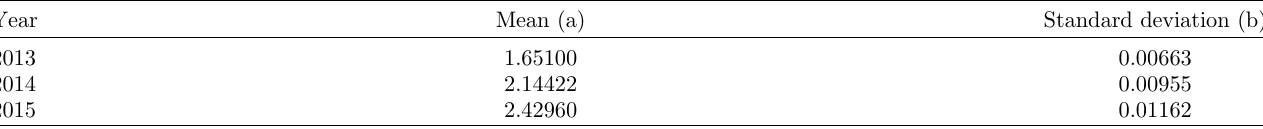
^ d ^ d ¼ B and u = 0.1, 0.15, 0.2.